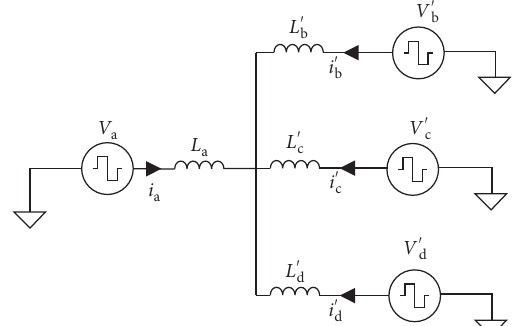
Figure 4: Equivalent model of high-frequency